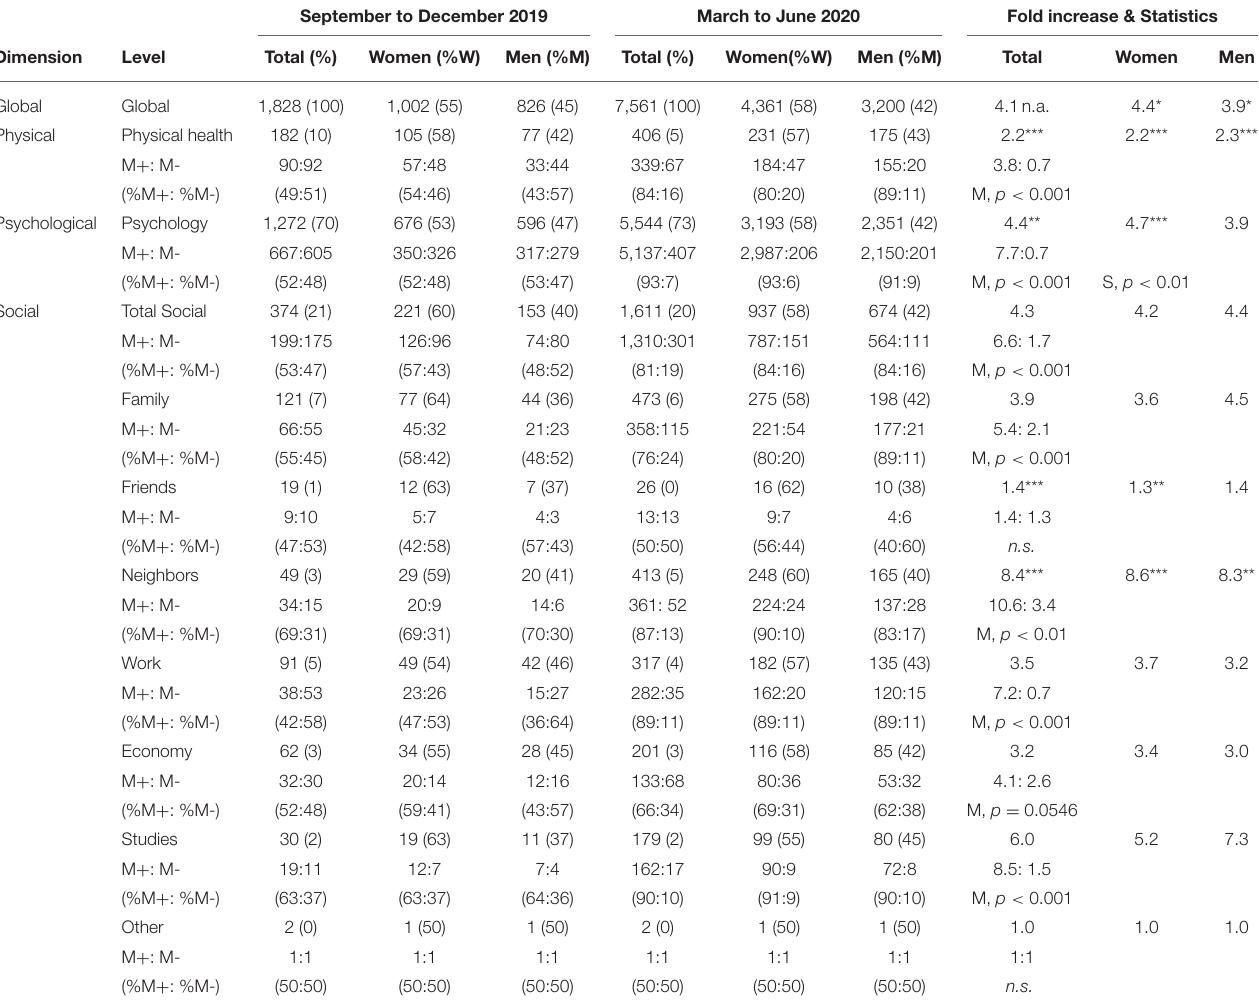
TABLE 2 | Results are expressed as total number and